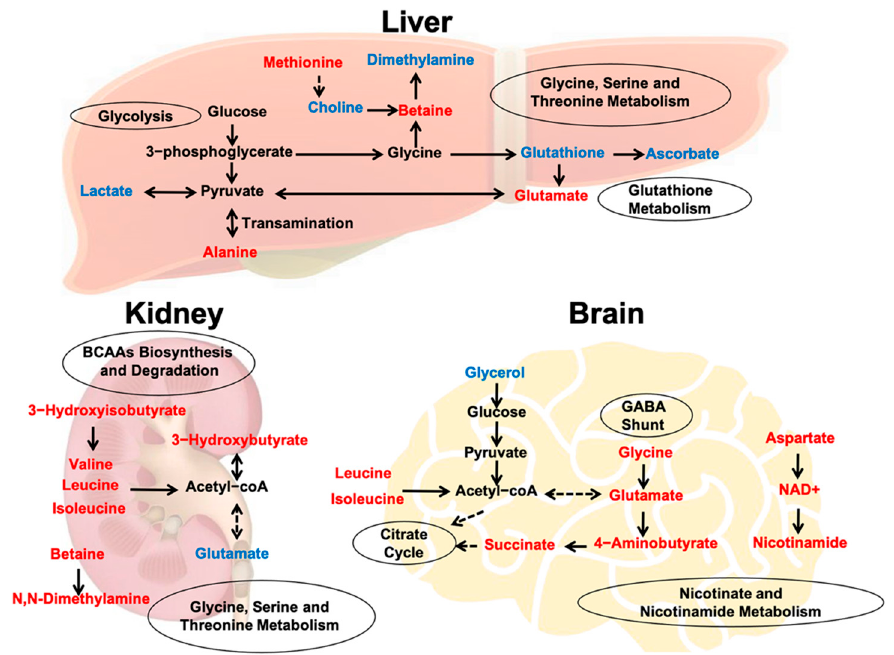
Figure 7. Overview of hypoxia altered metabolic pathways. Blue indicates the down-regulated metabolites, whereas red indicates upregulated metabolites. Hypoxic exposure significantly altered amino acid metabolism and energy metabolism, with glutamate changed in all the liver, kidney and brain.